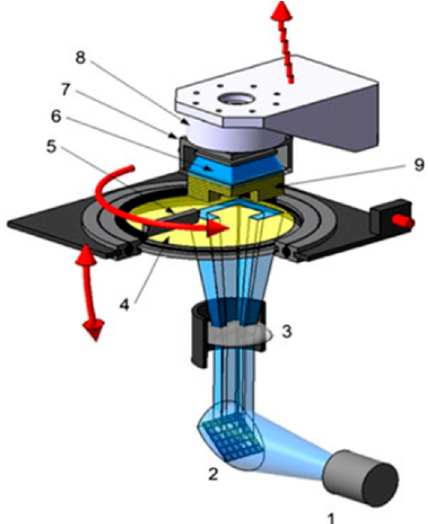
Figure 5. Schematic representation of an LCM machine: LED light source (1), DMD chip (2), optical lens (3), material vat (4), doctor blade (5), backwards exposure (6), building platform (7), load cell (8), part (9) [21]. Reproduced with permission from Passakorn Tesavibul; Ruth Felzmann; Simon Gruber;